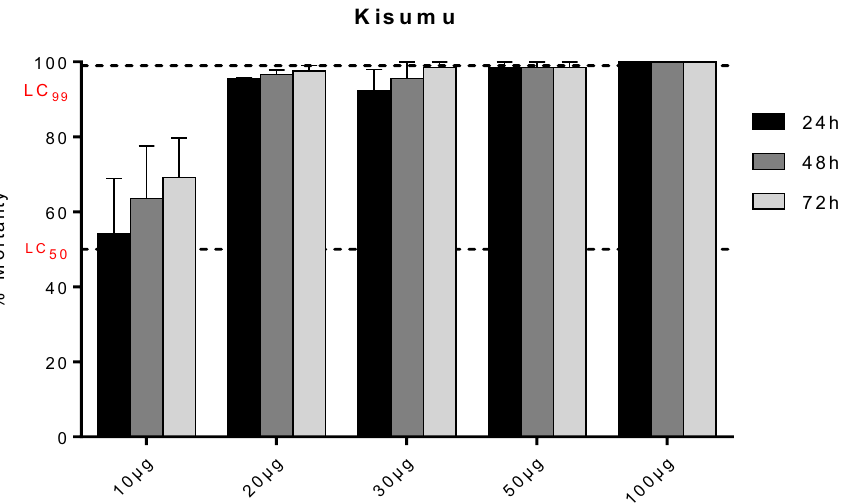
Figure 1. Assessment of diagnostic dose of chlorfenapyr using the susceptible lab strain Kisumu. Percentage mortality (24 h, 48 h and 72 h) of the susceptible lab strain Kisumu after exposure to chlorfenapyr (with acetone as solvent). LC50 represents the concentration able to kill 50% of mosquitoes and LC99 the concentration able to kill